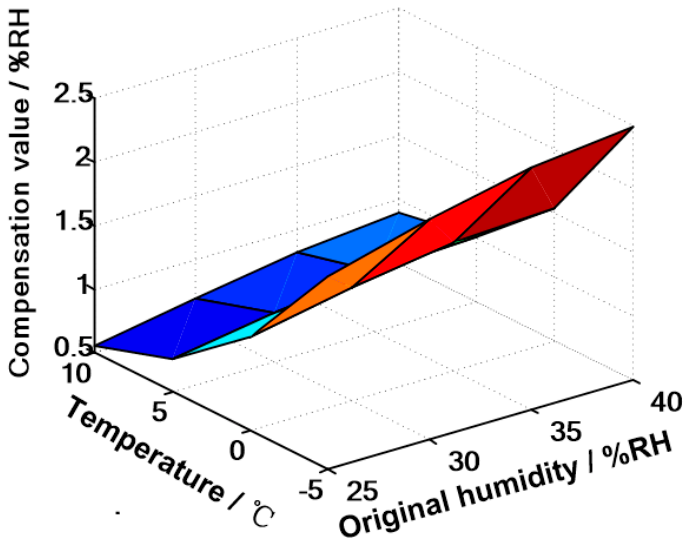
Figure 9. Compensation function model.